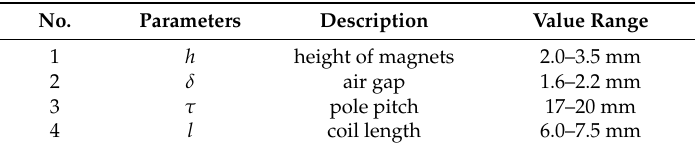
Table 1. Four main structural variables of the motor.